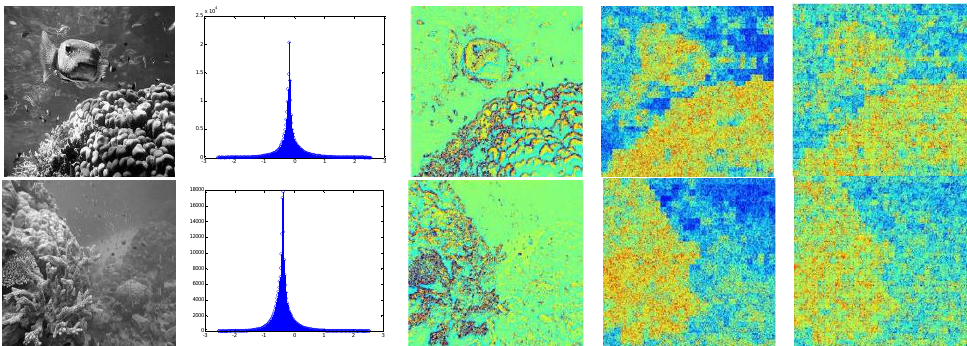
Figure 10. The activation maps for the underwater images in each